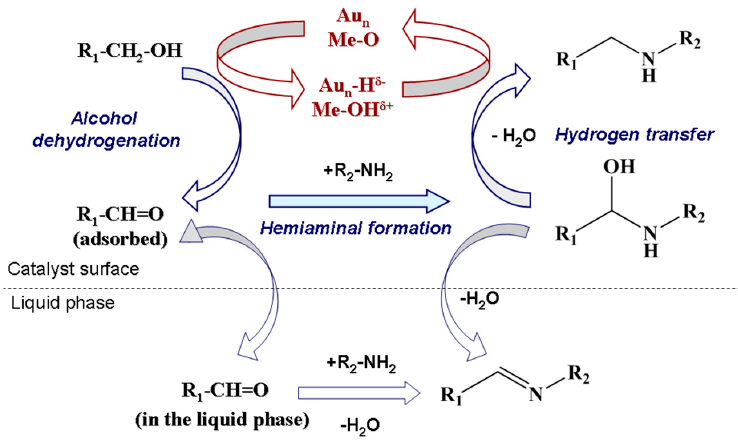
Figure 26. Proposed catalytic mechanism for myrtenol amination with aniline over Au on metal oxide MeO. Reprinted from [123] with permission from Elsevier.